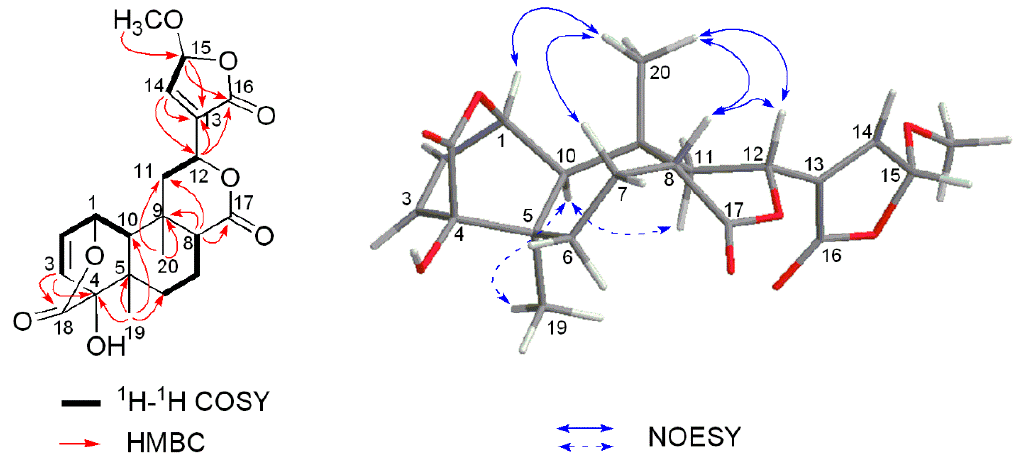
Figure 2. Key 1 H- 1 H COSY, HMBC and NOESY correlations of 1 .